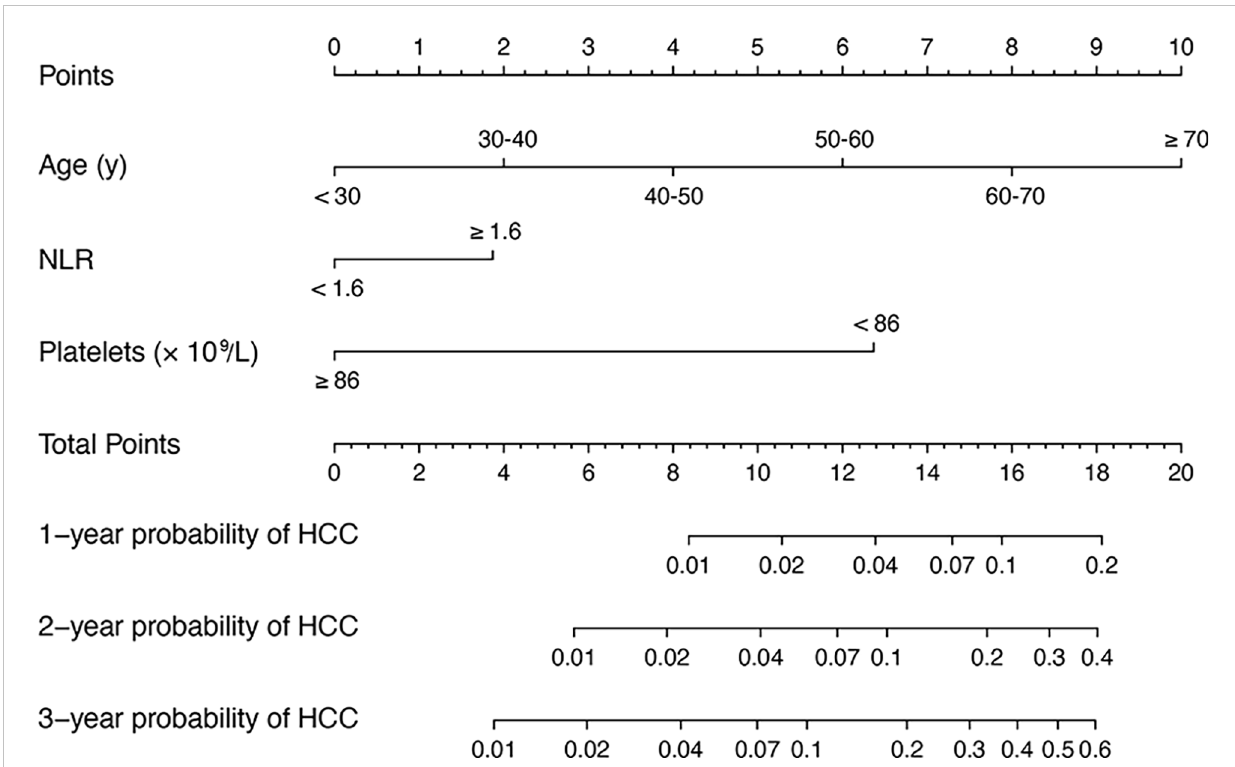
FIGURE 2 A nomogram for predicting 1, 2 and 3 years HCC risk in patients with hepatitis-B related cirrhosis. To use the nomogram, the value of an individual patient is located on each variable axis, and a line is drawn upward to determine the number of points received for the value of each variable. The sum of these numbers is located on the total point axis, and a line is drawn downward to PFS axes to determine the likelihood of HCC. HCC, hepatocellular carcinoma; hepatitis-B related cirrhosis, hepatitis B-related